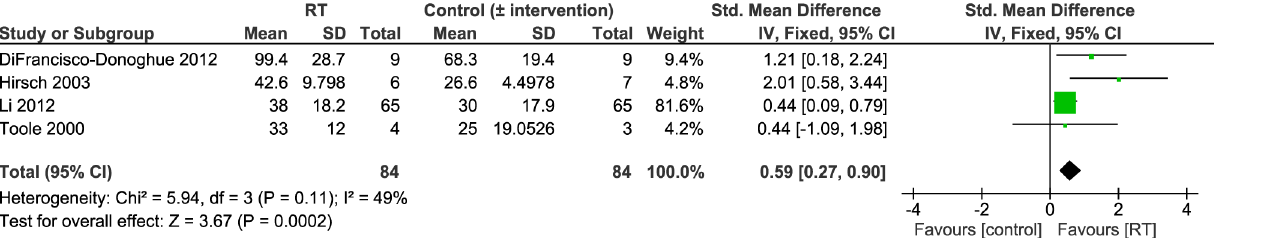
PLOS ONE | DOI:10.1371/journal.pone.0132135 July 6,